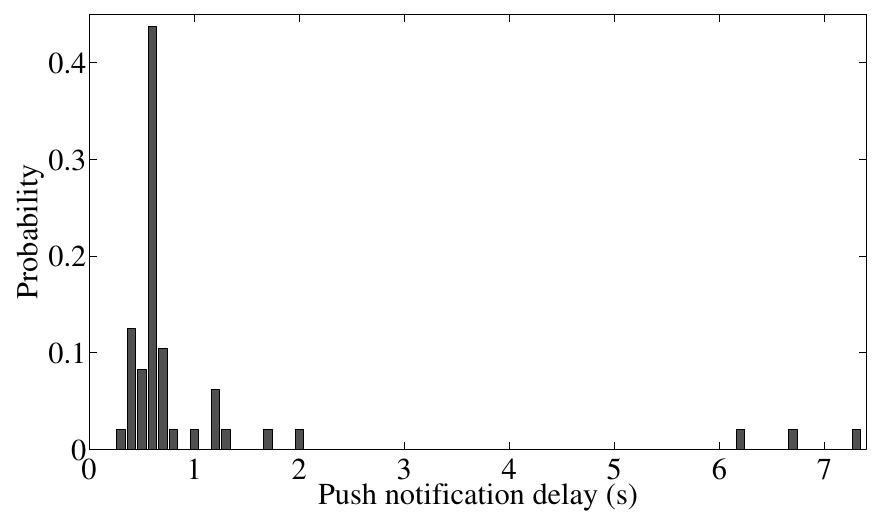
Figure 7. Empirical PDF of round trip time of Facebook friendship request push